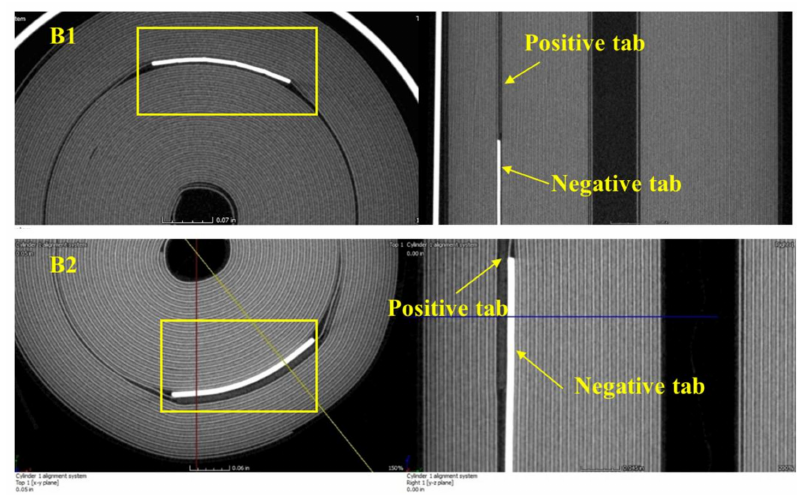
Figure 20. Electrode tabs of the samples B1 and